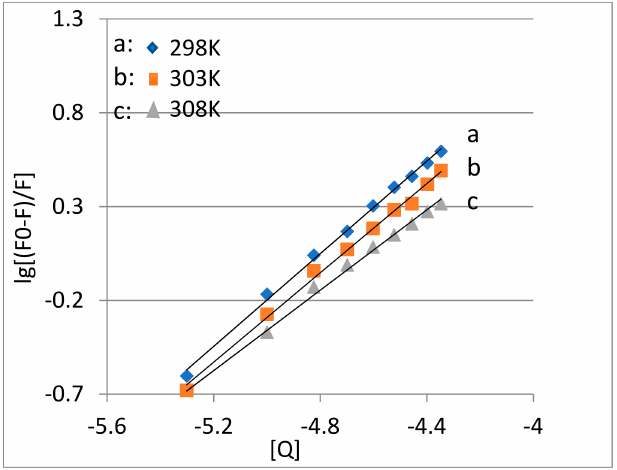
Figure 3. The Scatchard equation for the quenching of TRP by MC at different temperatures.